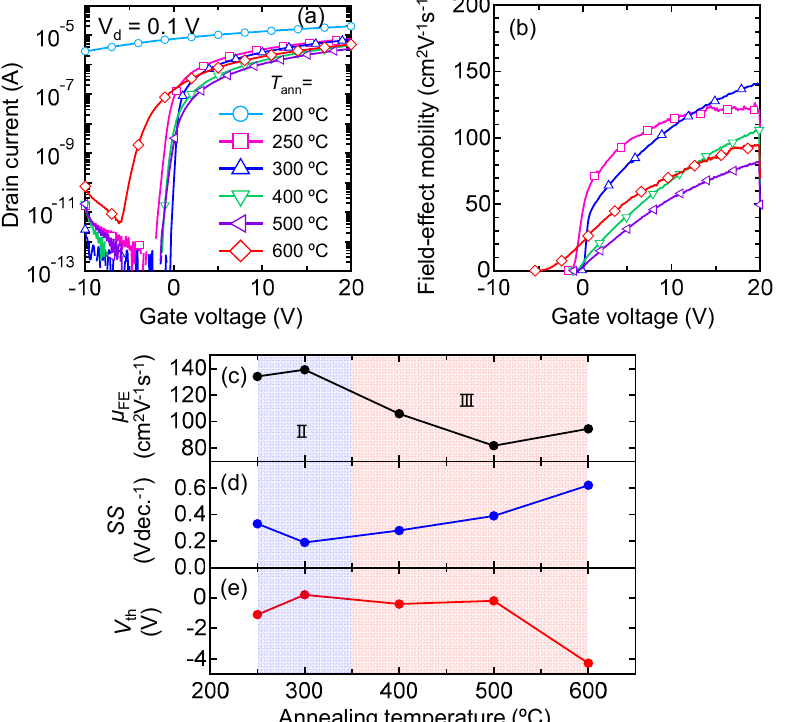
Figure 2. ( a ) Transfer characteristics and ( b ) µ FE of the In 2 O 3 :H TFTs with channels annealed at various temperatures; T ann dependence of ( c ) µ FE , ( d ) SS , and ( e ) V th in the In 2 O 3 :H TFTs.